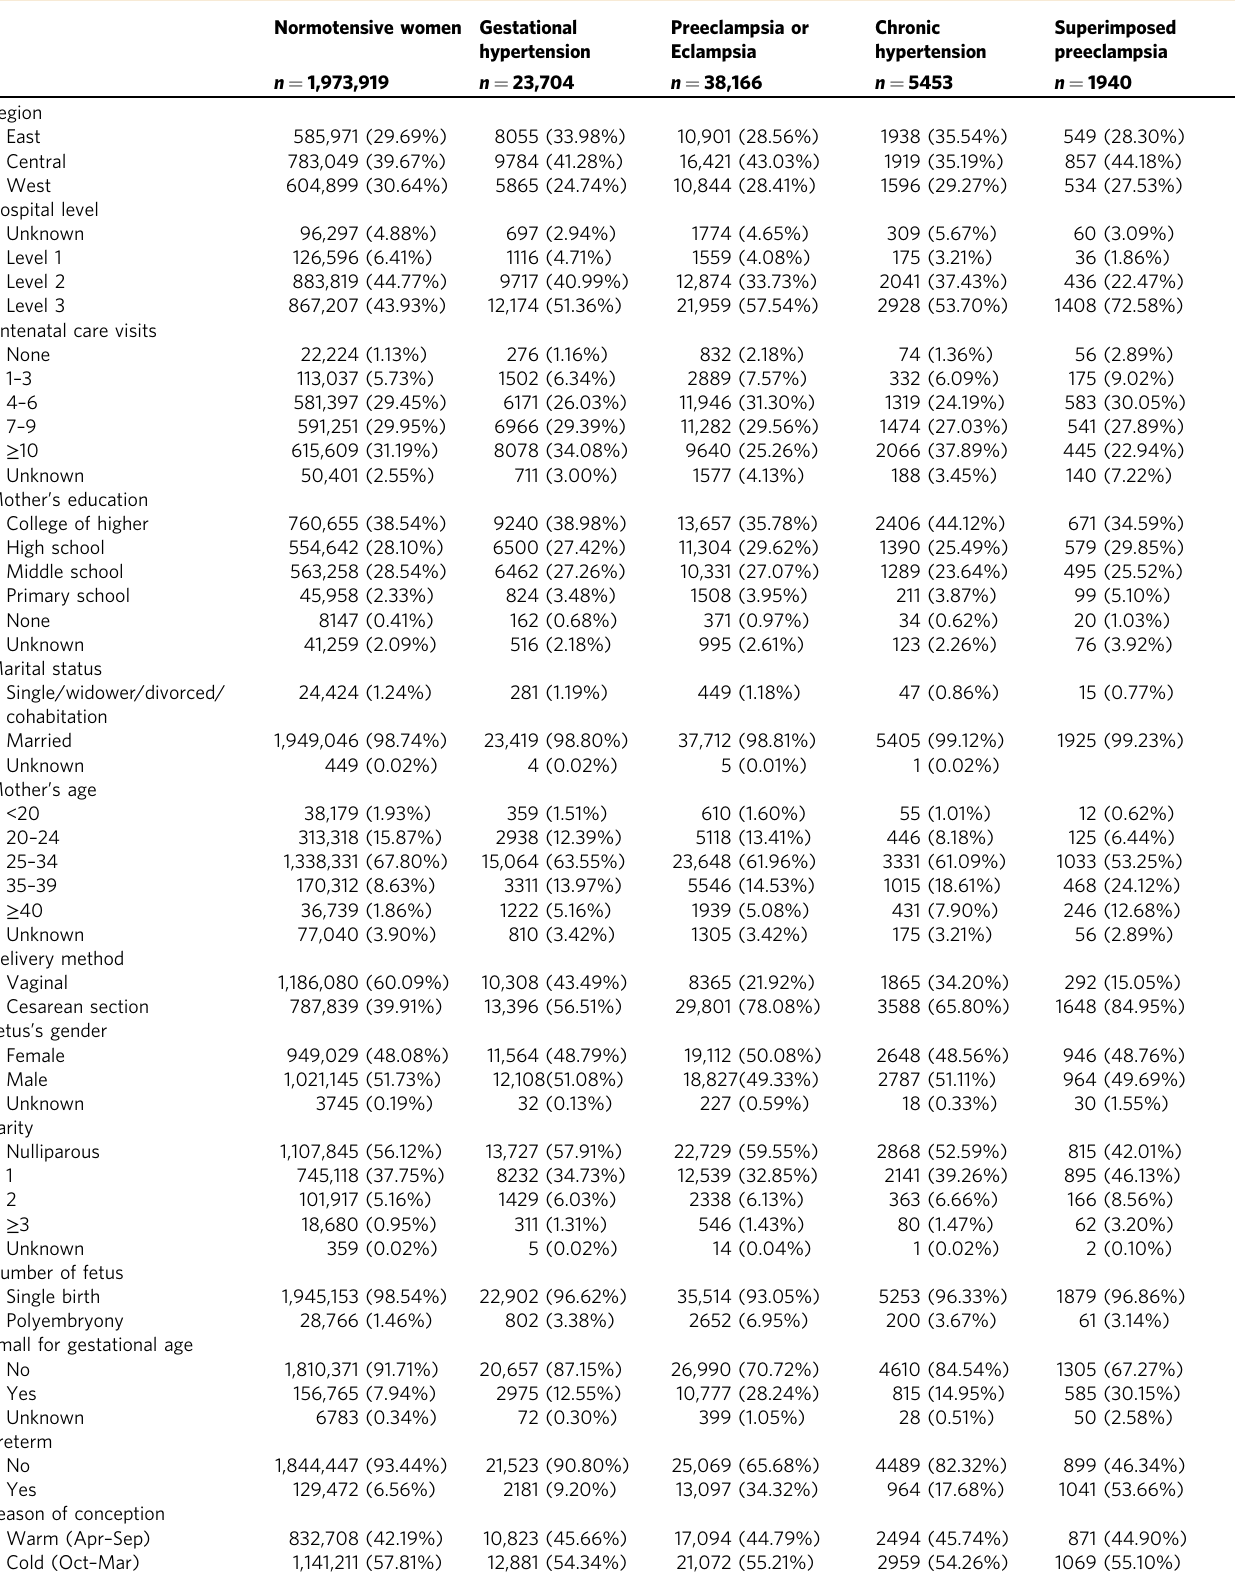
Table 1 Sociodemographic characteristics of pregnant